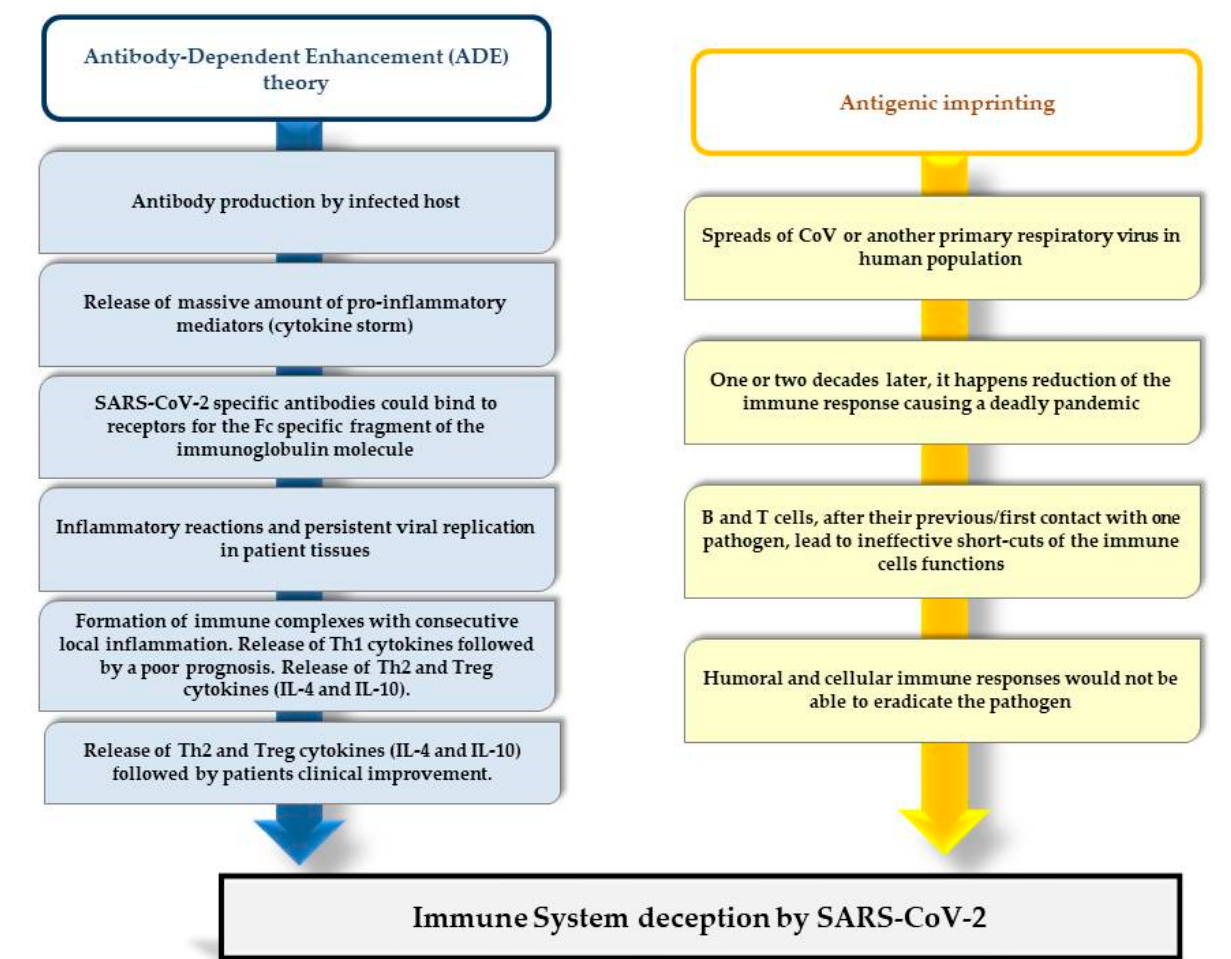
Figure 1. Schematic view of Immune System role during SARS-CoV-2 infection. The antibody-dependent enhancement (ADE) theory is shown in blue, the antigenic imprinting in orange.